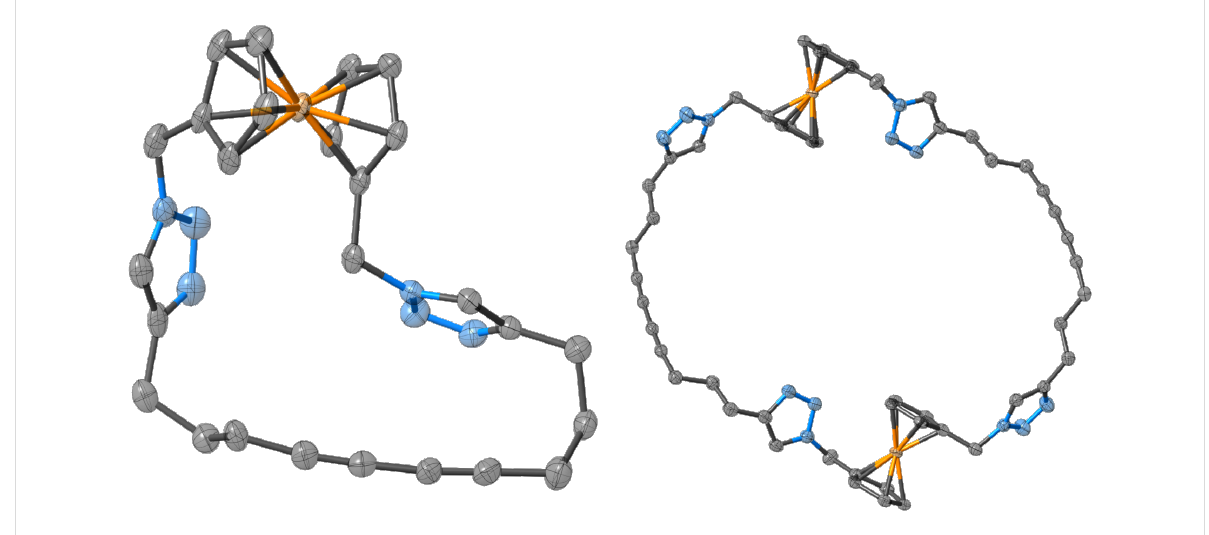
Figure 1: Solid-state structure of 3 (left) and 4 (right). Hydrogen atoms omitted for clarity, ellipsoids are shown at 50% probability; only one of the two independent molecules in the asymmetric unit of 3 is shown. Colour scheme: grey = carbon, blue = nitrogen, orange = iron.